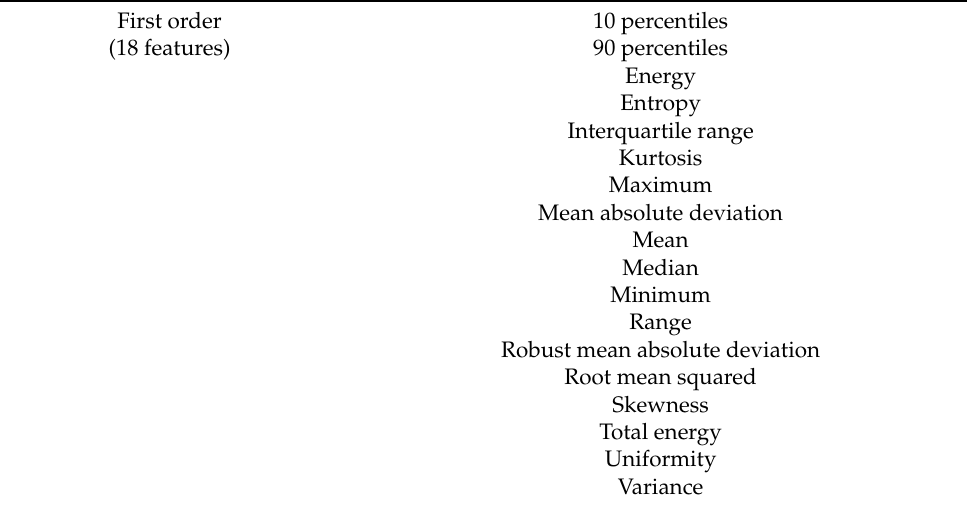
Table A2. From original image and images filtered by 8 wavelet transform filters (HHH, HHL, HLH, HLL, LHH, LHL, LLH,